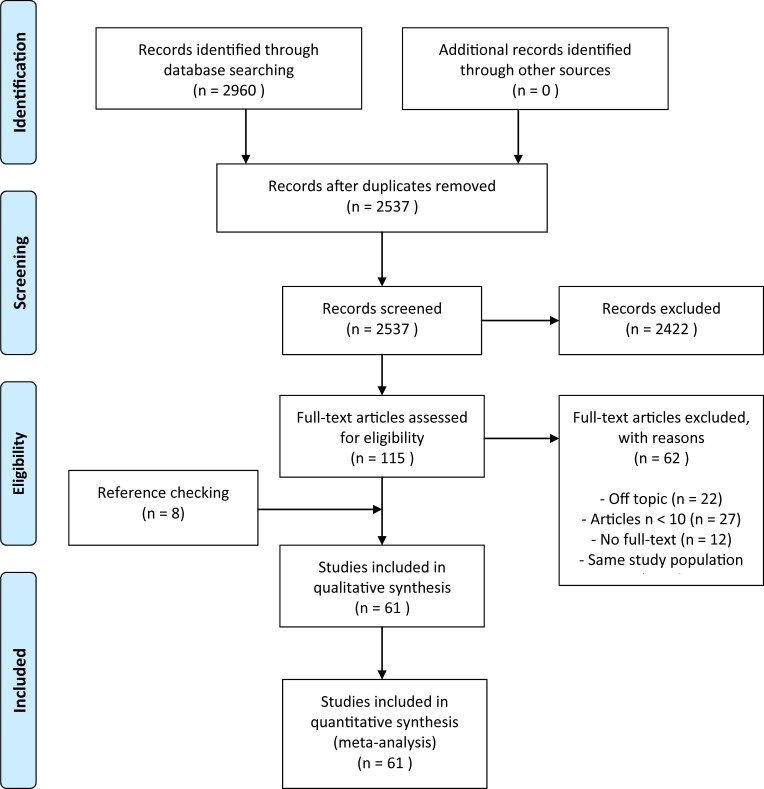
Flowchart showing the inclusion process.